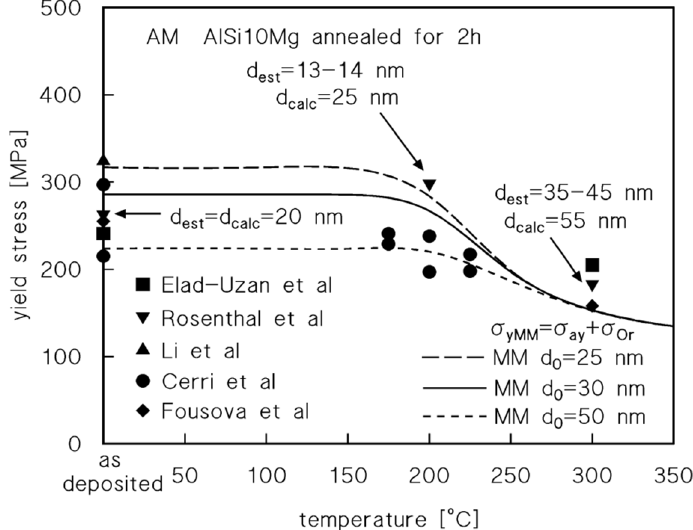
Figure 1. Effect of a 2-h postprocessing heat treatment on yield strength (on the left, the values for the as-deposited alloys) [5,10–13]. The figure also plots the roughly estimated value of the yield stress calculated by taking into account the effects of the Ostwald ripening of Si particles of different initial size (see Appendix A for details on the calculation of the Si particle size d calc , and Table 1 for the meanings of symbols). In addition, data on the observed crystallite size, d est , are reported [5].